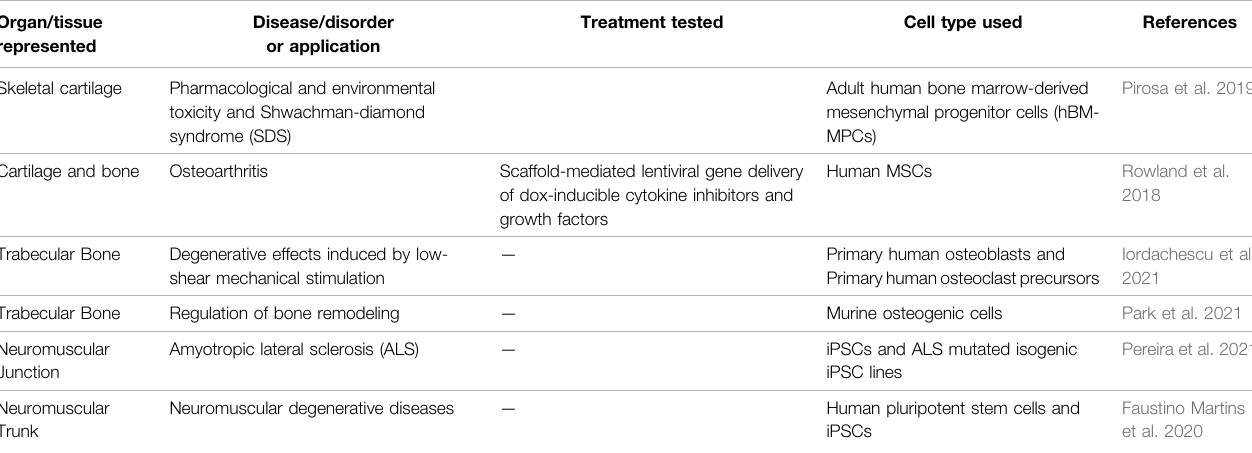
TABLE 1 | Examples of organoid models of musculoskeletal tissues and organs. Organ/tissue